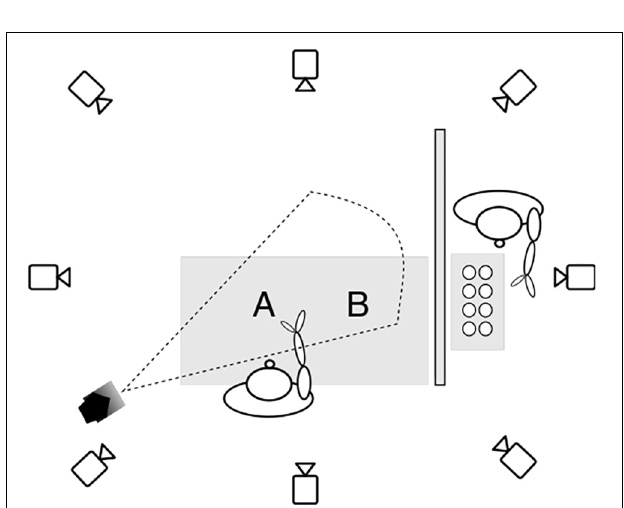
FIGURE 2 | The experimental setup in the motion capture studio. The cups were kept hidden behind a divider and presented by the experimenter one at a time to the participant on location A. Then the participant reached for the cup on location A and transported it to location B. The horizontal distance between locations A and B is 40 cm, and the vertical distance between location A and the start position is 40 cm. The spotlight is positioned on the left of the participant with a distance of 140 cm from location A, casting light